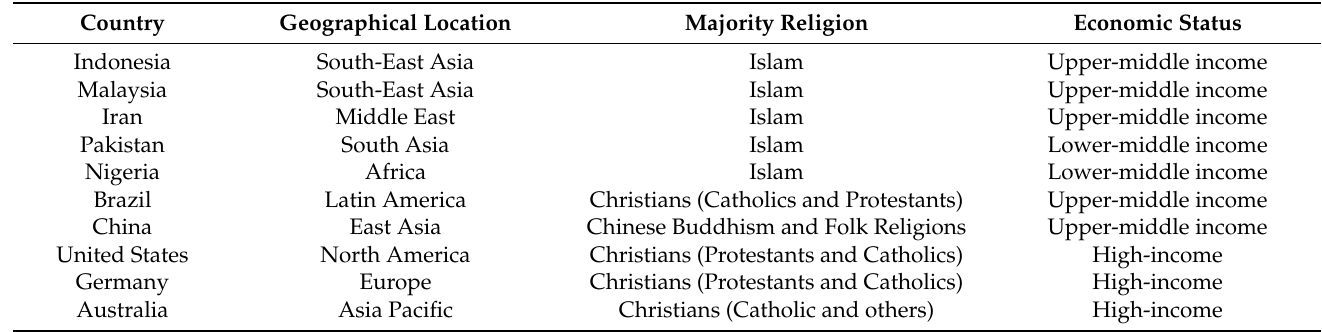
Table 1. Studied countries. Source: